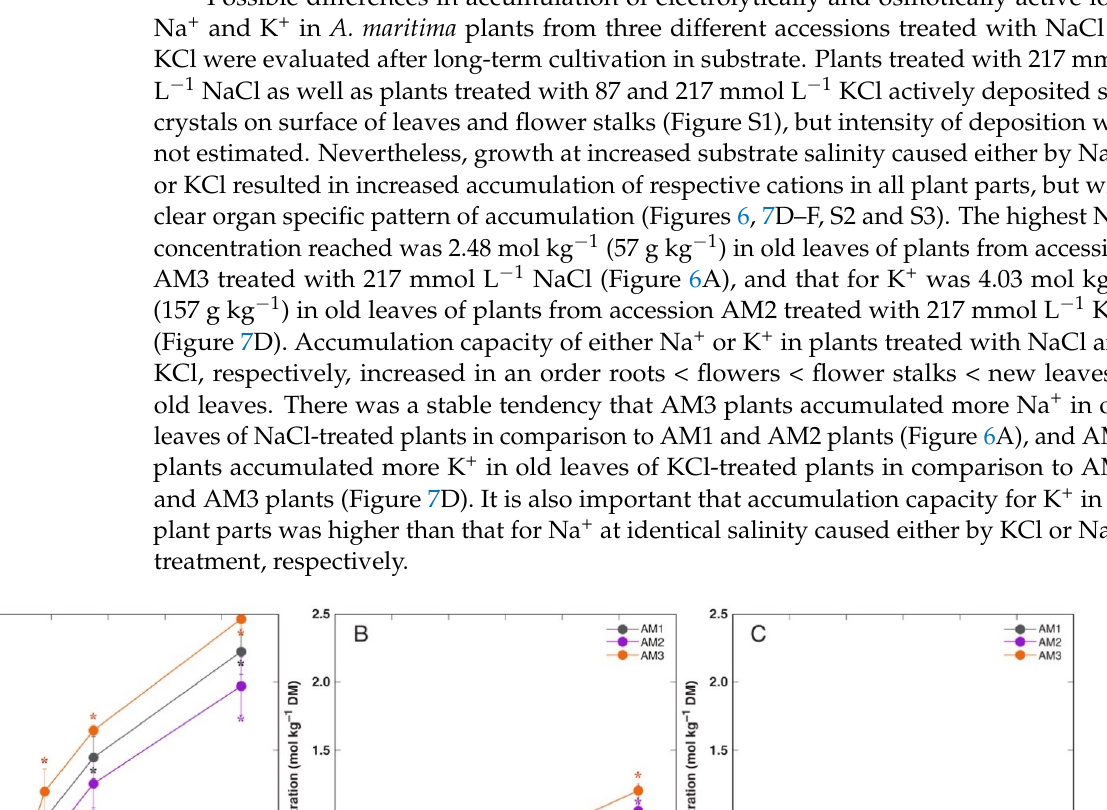
Figure 7. Effect of added NaCl ( A – C ) and KCl ( D – F ) concentration in soil on accumulation of K + in old leaves ( A , D ), new leaves ( B , E ) and flowers ( C , F ) of Armeria maritima plants from different acces- sions after 7–8 weeks of cultivation. DM, dry mass. Data are means ± SE from 3 replicates. Asterisks of respective color indicate statistically significant differences ( p < 0.05) from control. For NaCl-treated plants, increased salinity resulted in a significant reduction in K + concentration in old leaves for all accessions (Figure 7A) and new leaves for AM1 and AM2 (Figure 7B). Effect of NaCl treatment on K + concentration in generative parts and roots differed between accessions. Thus, it significantly increased in flowers (Figure 7C)